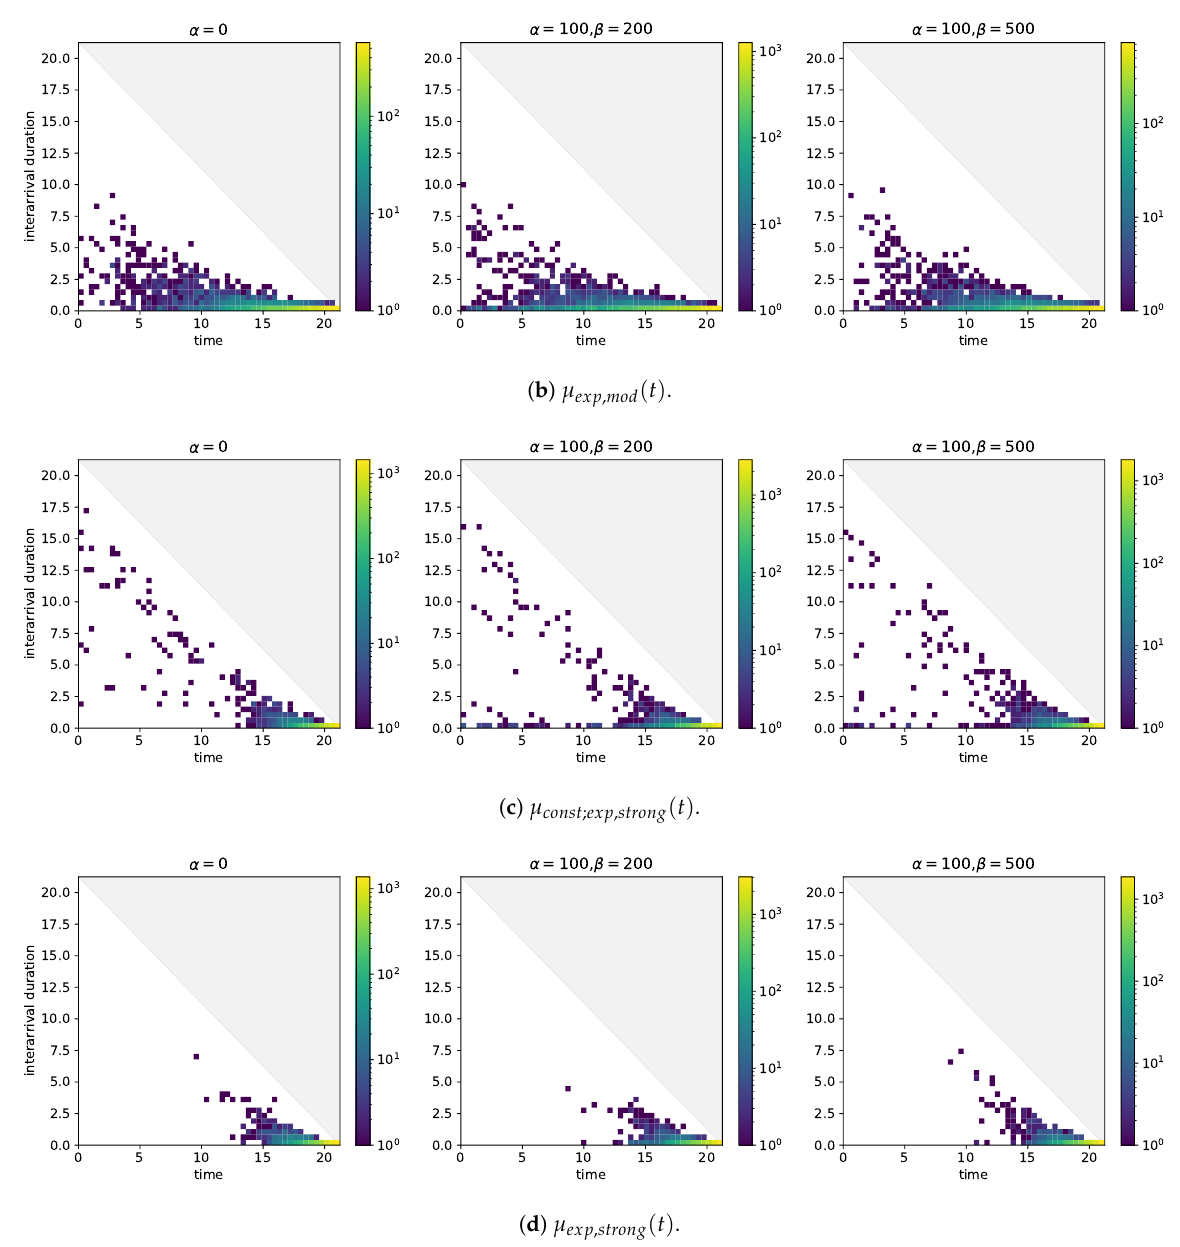
Figure A2. Two-dimensional histograms of event arrival times (horizontal axis) and durations between event arrival times and the arrival time of the next event (vertical axis) for different baseline intensities and self-excitation structures. T = 21.25, N = 10 2